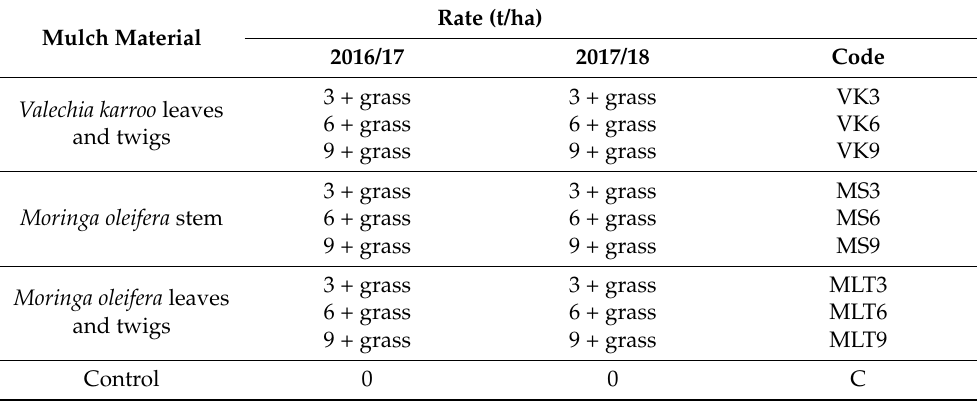
Table 1. Experimental treatments applied during 2016/17 and 2018/19 growing seasons. Mulch